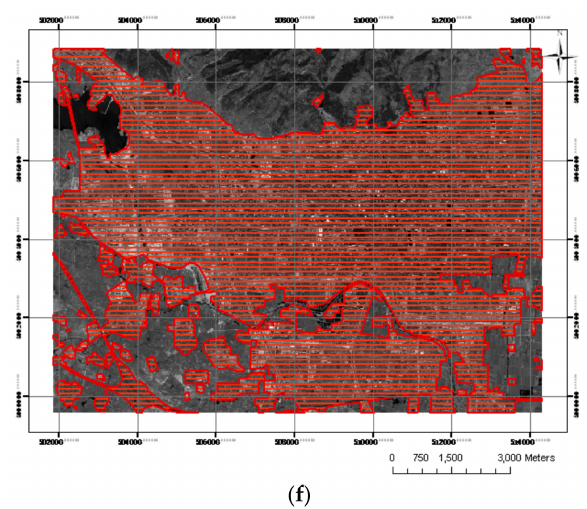
Figure 6. The second test image; the results of our method and the extracted built-up areas. ( a ) The VHSR satellite image; ( b ) the retained corners and line segments; ( c ) the constructed thematic image by spatial voting; ( d ) the final built-up area (by our proposed method) imposed on the original image; ( e ) the final built-up area by the PanTex method; ( f ) the reference built-up area. The third is a QuickBird panchromatic image with a size of 6904 × 6905 pixels. The GSD is 0.61 m, and the covered area is located in the central urban area of Linzhi City, Tibet Autonomous Region, China, as shown in Figure 7a. Similar to the second set of data, the third set of data covers built-up areas, rivers, forests, grass land and bare lands, as shown in Figure 7a. Moreover, many islands are located in the rivers. The road lane markings are not observed.